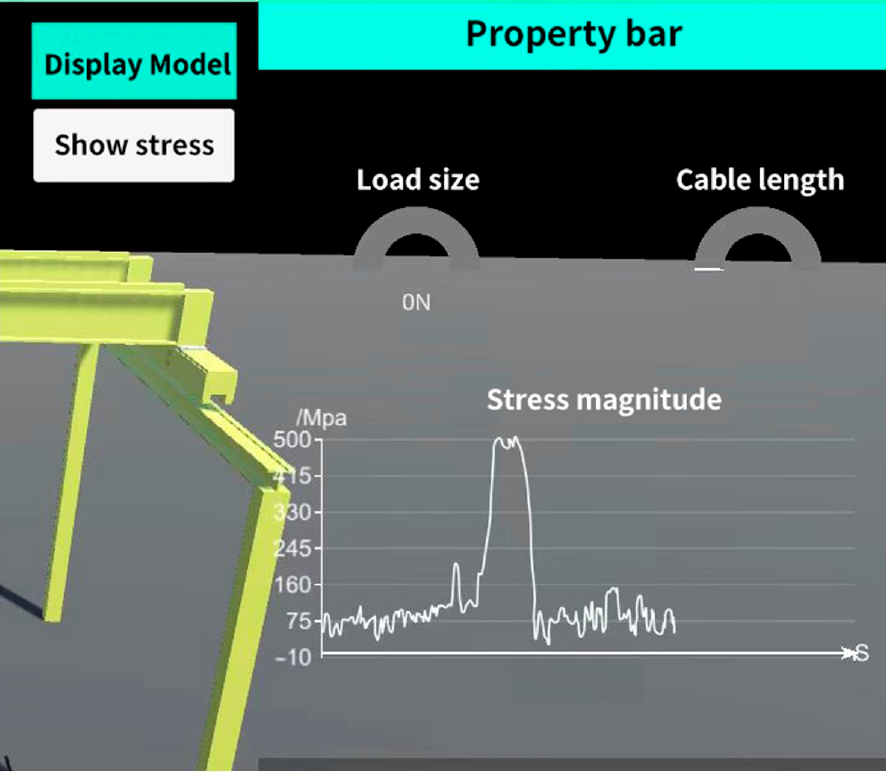
Figure 5. The development of the stress module.